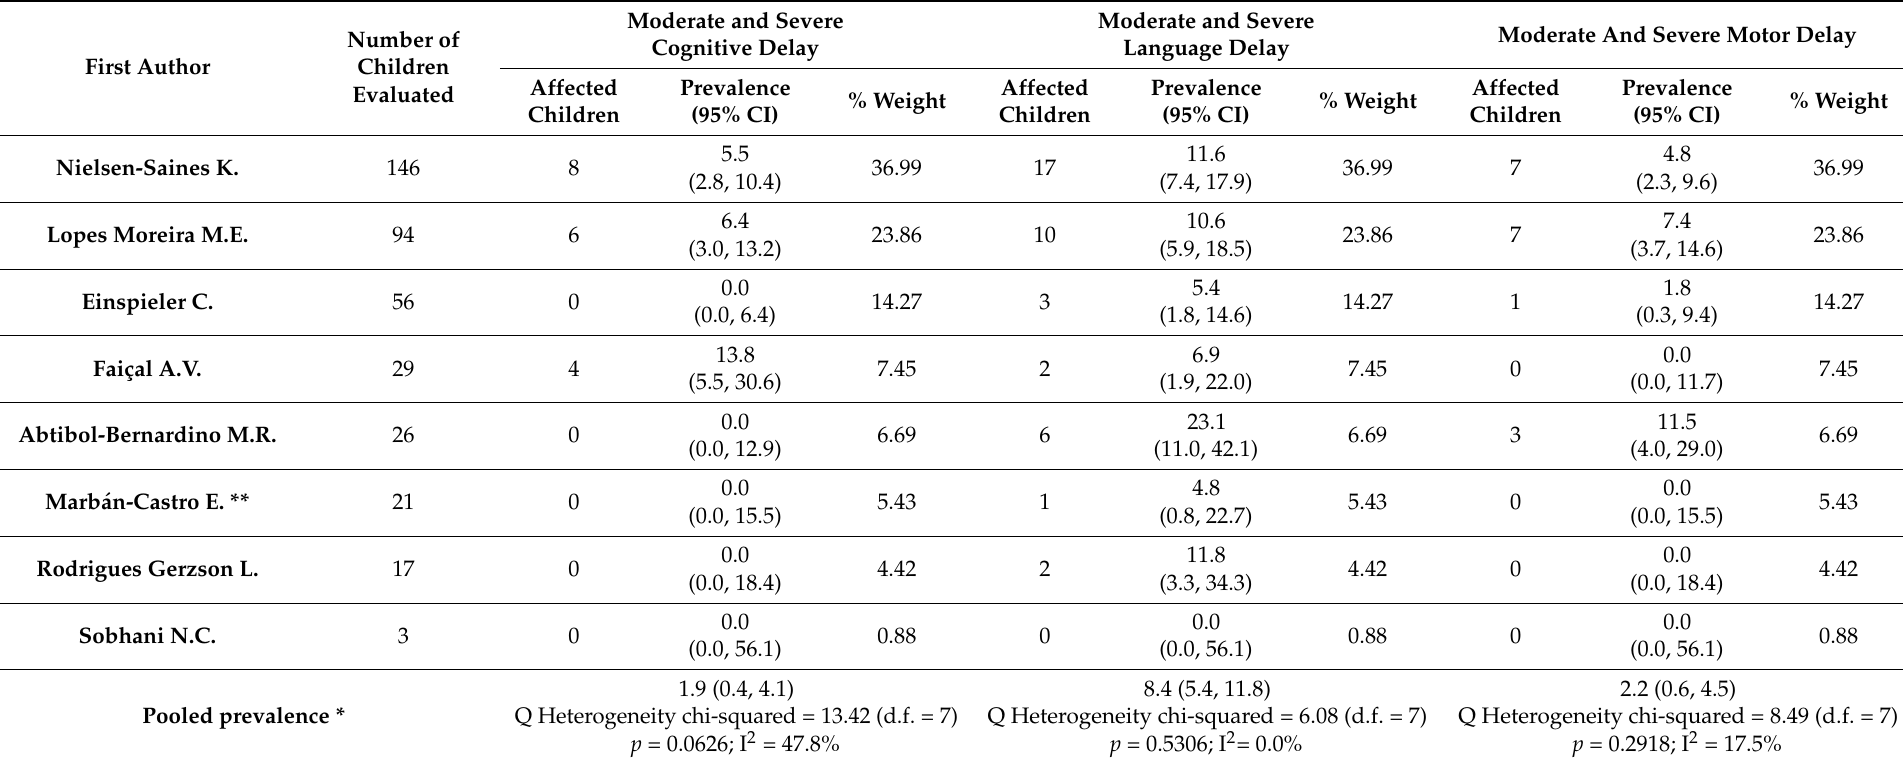
Table 4. Disaggregated data, prevalence, and weight of each study in the meta-analysis for moderate and severe delay in the cognitive, language, and motor domains using the BSID-III